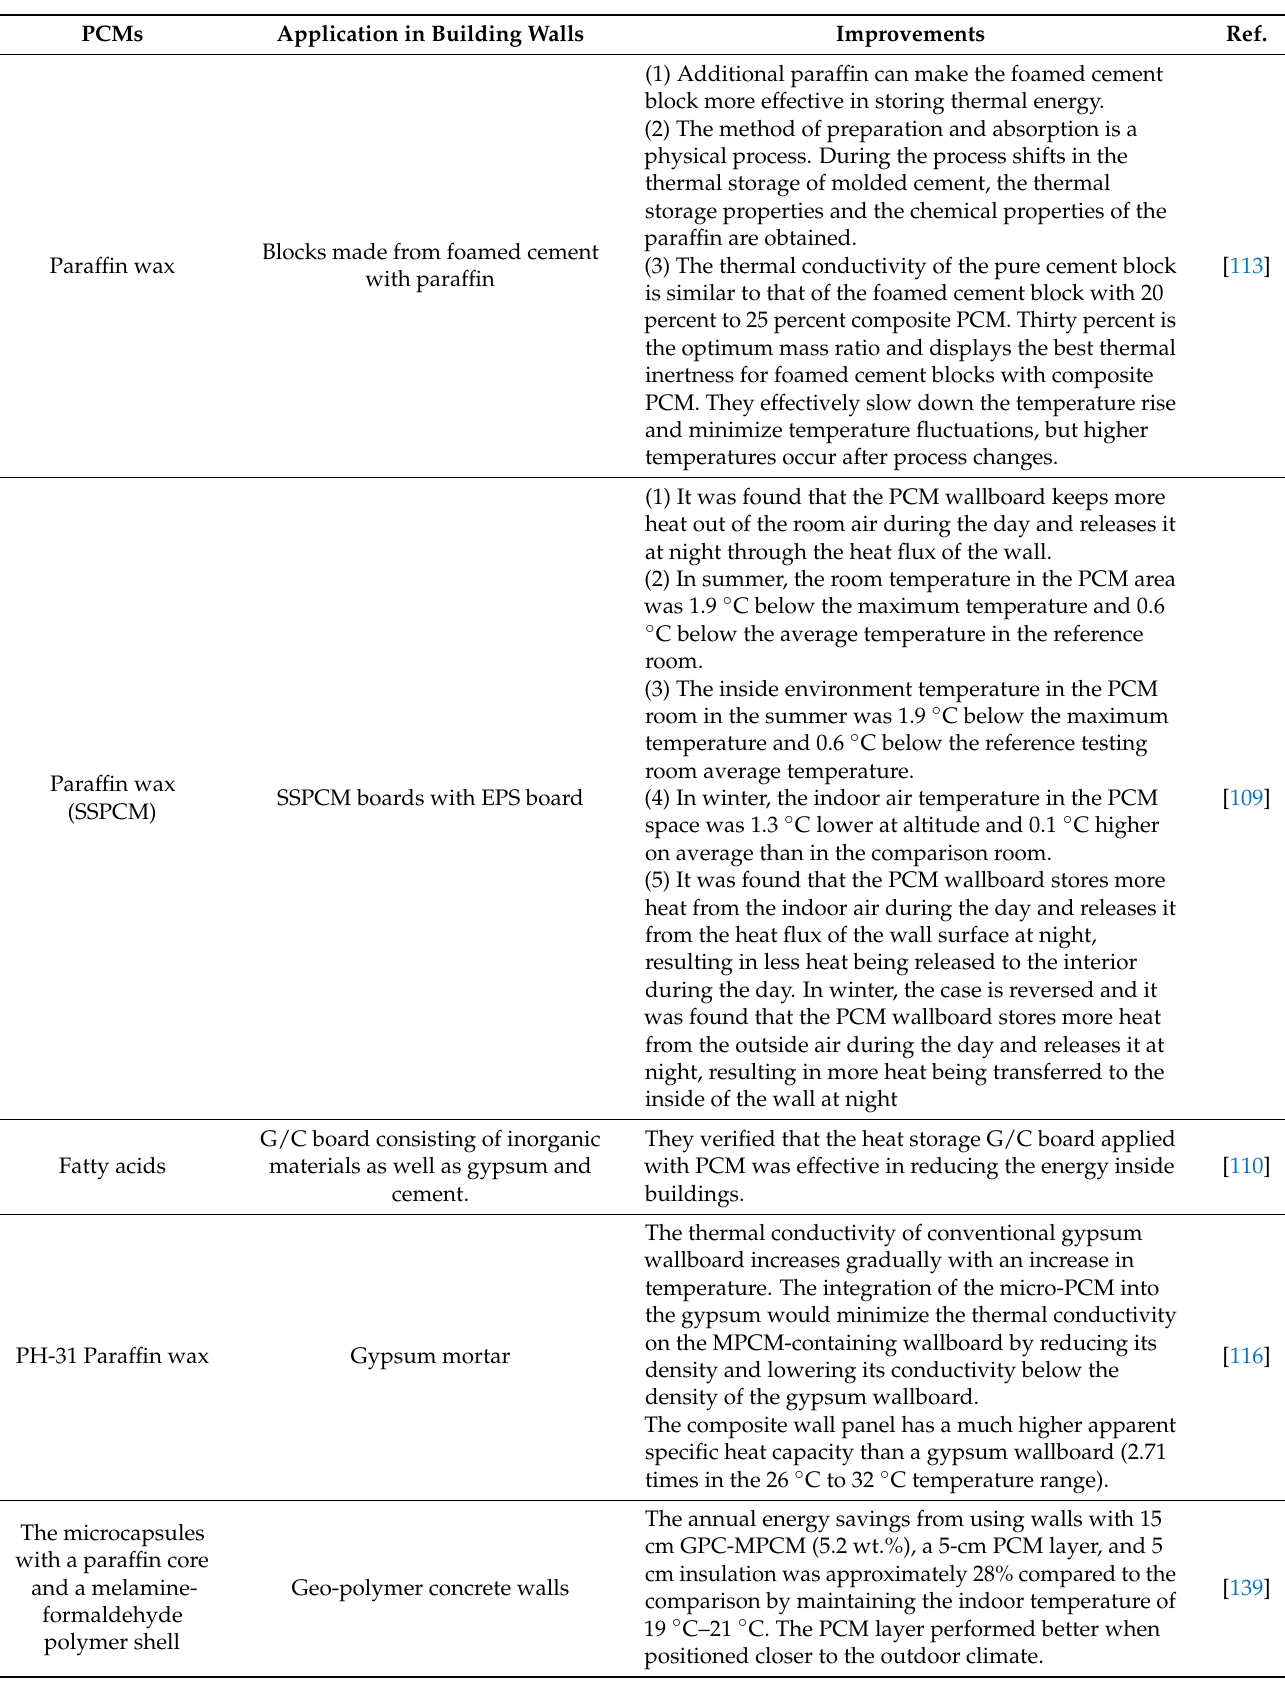
Table 8. Summary of different experimental studies in 2019 from the literature on wall